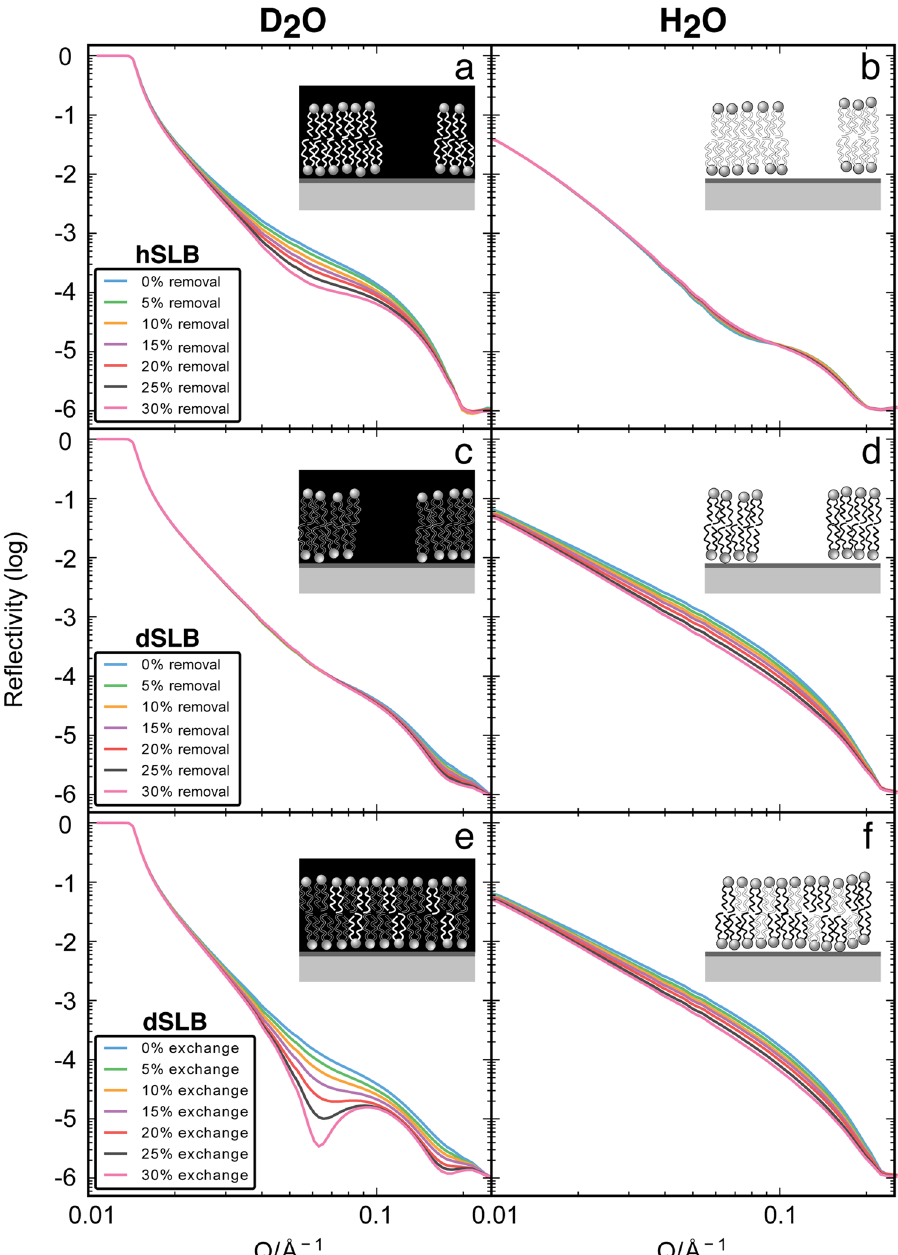
Figure 1. Simulated reflectivity profiles for hydrogenated (h-) or tail deuterated (d-) SLBs. ( a ) and ( b ) show the effect of lipid removal from the bilayer on a h-SLB in D 2 O and H 2 O, respectively, while ( c , d ) show the removal process on a d-SLB. ( e , f ) show the effect of replacing tail-deuterated lipid molecules in the d-SLB with hydrogenated material from a model lipoprotein in both D 2 O ( e ) and H 2 O ( f ). Inset to each graph depicts lipid exchange or removal described in the simulated reflectivity changes. SLD is shown on a greyscale with material of a high SLD (deuterated) in black and low SLD (hydrogenated) in white. For clarity rearrangement after lipid removal has not been depicted, further discussion can be found in the